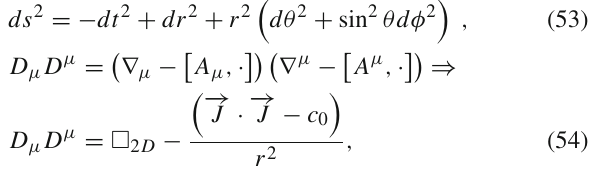
Fig. 3 The entropy functions with κ = (cid:4) = r 0 = 1. The green and red curves are the graphs of S I and S II , respectively. The last two fig- ures show two different regions for the same physical parameters. For the case with e = 1 and λ = 100, the interval 0 . 29 < x < 1 . 71 is